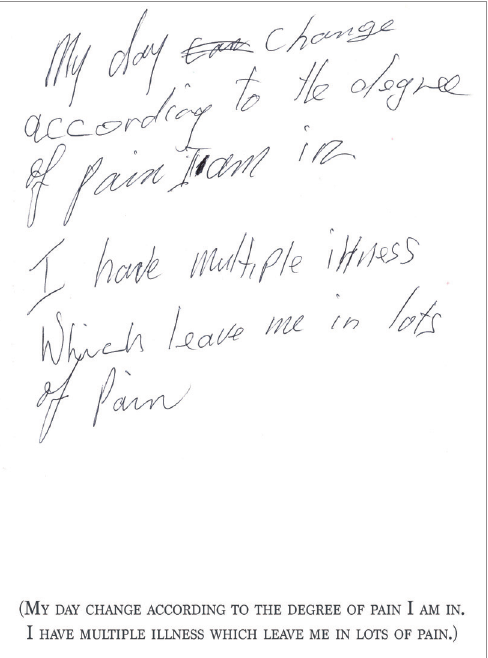
Figure 4: A handwritten image by a stroke survivor from the series ‘Different